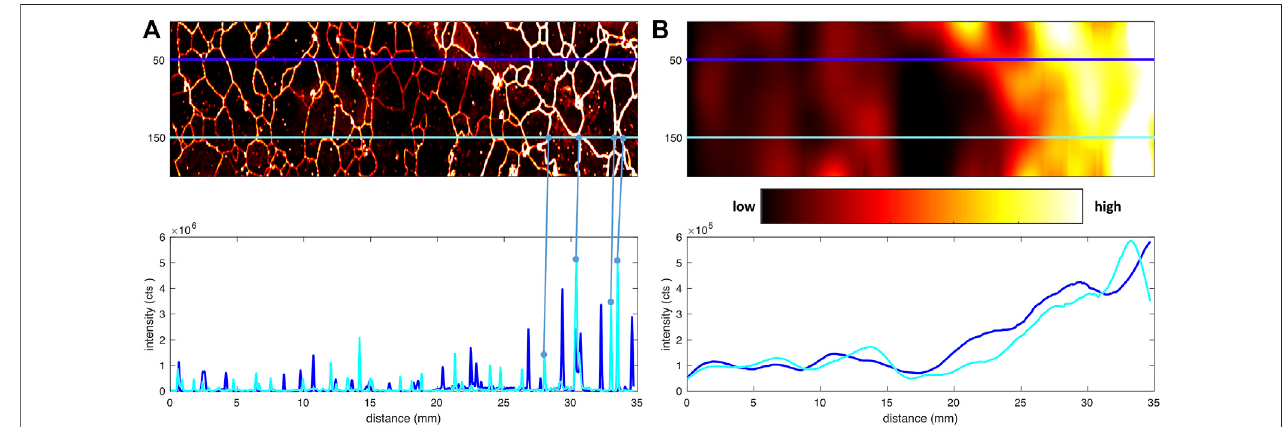
FIGURE 2 | Image (A) shows the original Na image (7 mm × 35 mm). The example of two individual line pro fi les (the dark and light blue lines, two of the 200 horizontal lines that make up this image) reveals how the signi fi cance of single peaks (the fi ne scale signal components) is tied closely to the grain boundaries in the ice crystalnetwork(illustratedbyfoursampleconnectinglines).TheimprintofthegrainboundariesontheLA-ICP-MSsignalsweakensiftheresolutionisdecreasedandthe scaleisincreased,respectively.Thisisillustratedbyimage (B) ,obtainedbyapplying2DGaussiansmoothingtoimageA(30 pixelstandarddeviation).Inimage (B) , the two lines spaced 100 pixels (350 μ m) apart show a high degree of similarity, the coarse scale components now representing mainly the overall intensity gradient of the